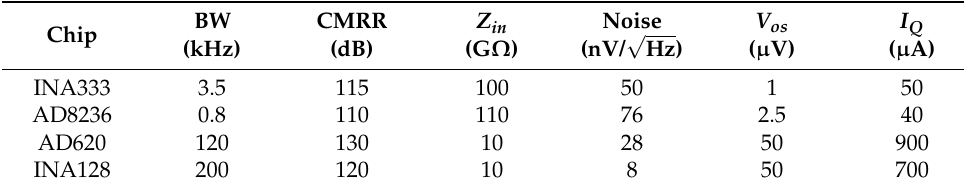
Table 1. Comparison of In-Amp parameters (gain = 100).